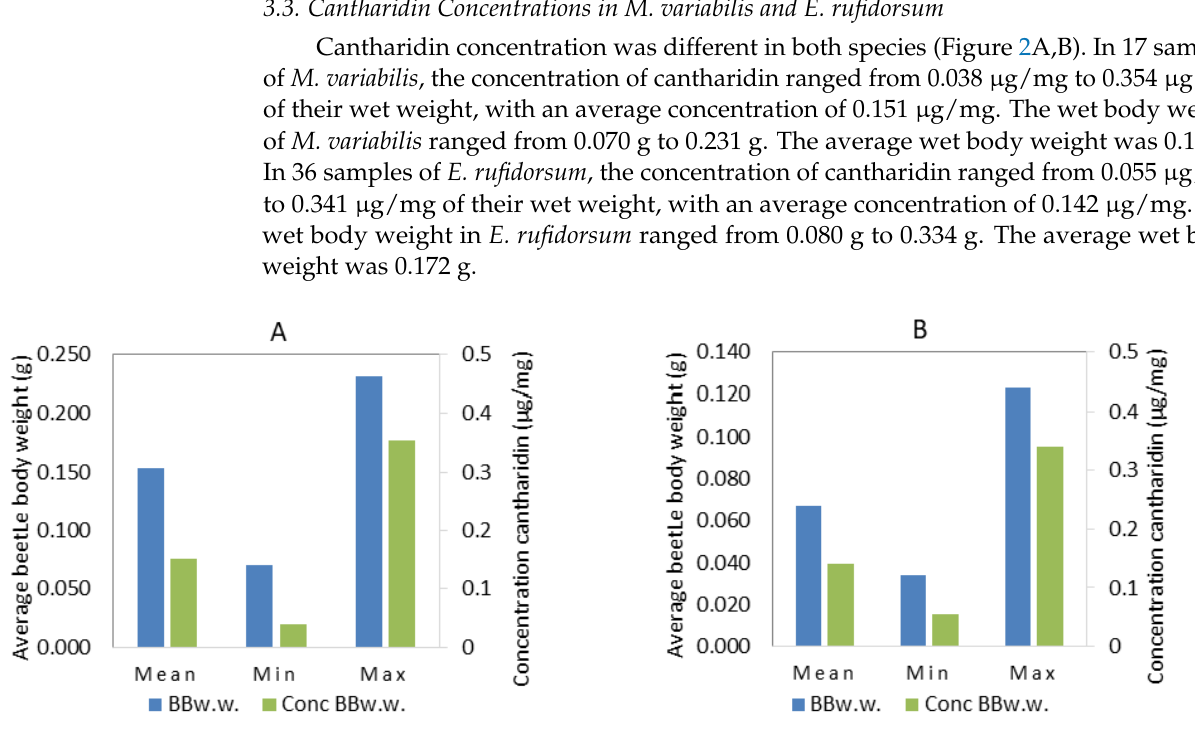
Table 2. Body weight and cantharidin concentration in Mylabris variabilis and Epicauta rufidorsum. Species